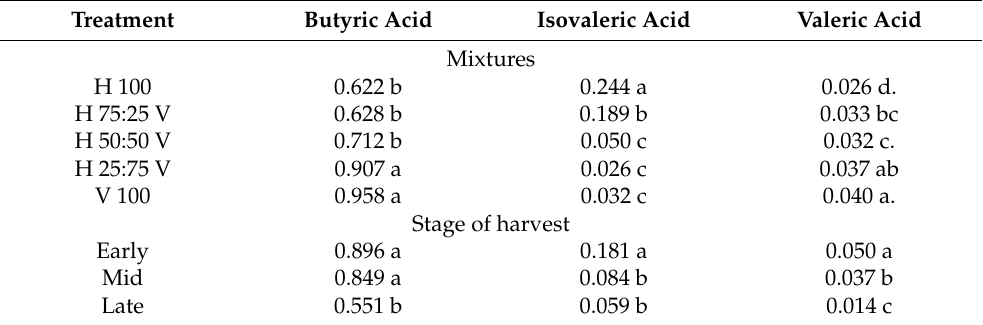
Table 3. Concentration (%) of butyric, isovaleric and valeric acids in silage as affected by MX and SH mean